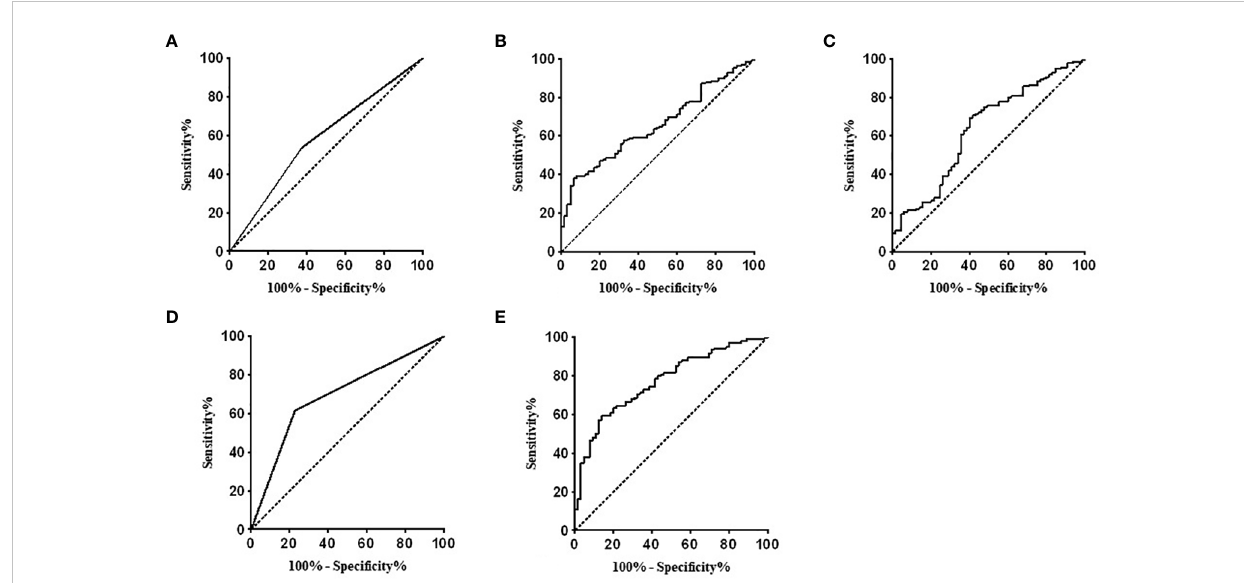
FIGURE 2 Receiver operating characteristic curve analysis evaluating the diagnostic performance for tumor diameter in patients with PPGLs. (A) The AUC of the male for predicting the large tumor was 0.582 (95% CI: 0.512 – 0.651, p=0.024). (B) The AUC of the 24U-E concentrations for predicting the large tumor was 0.656 (95% CI: 0.581 – 0.731, p<0.001). (C) The AUC of the 24hU-NE concentrations for predicting the large tumor was 0.637 (95% CI: 0.554 – 0.720, p = 0.002). (D) The AUC of the adrenal PPGLs for predicting the large tumor was 0.694 (95% CI: 0.629 – 0.758, p<0.001). (E) The AUC of the whole model for predicting the large tumor was 0.772 (95% CI: 0.706 – 0.834, p < 0.001). PPGLs, pheochromocytomas and paragangliomas; AUC, area under the curve; 24hU-E, 24-hour urinary epinephrine; 24hU-NE, 24-hour urinary